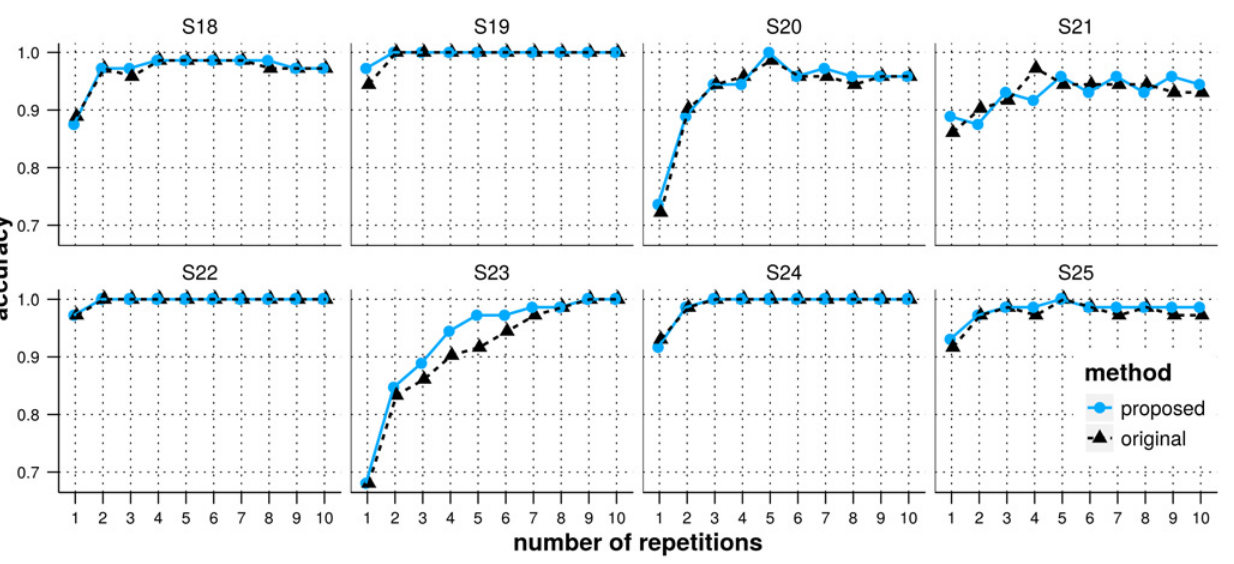
Fig 10. Accuracy of SSVEP detection. The x-axis represents the number of repetitions. Results are shown for all subjects and for both the original method averaging SNRs across harmonics (red) and the proposed method training an SVM for each subject in order to weight optimally each harmonic